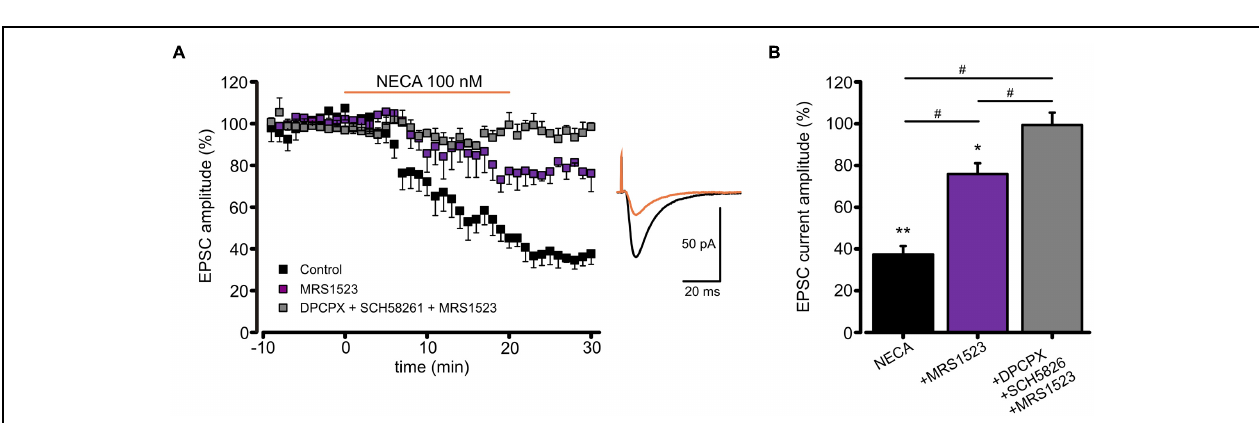
FIGURE 6 | Modulation of EPSC amplitude by NECA depends on A 3 R. (A) Left , time course of EPSC depression induced by adenosine receptor agonist NECA (100 nM) in hippocampal CA1 neurons in from acute slices in control conditions (black; n = 7; p < 0.05 at t = 25 min), in the presence of A 3 R antagonist MRS1523 (100 nM) (purple; n = 7; p < 0.05 respect to control and NECA alone) and in the presence of DPCPX + SCH58261 + MRS1523 (gray, n = 7). Right , sample EPCSs recorded in a CA1 pyramidal neuron in control and following NECA application. (B) Bar chart showing the effect of NECA (100 nM) alone (black), in the presence of the A 3 R antagonist (MRS1523 100 nM, purple) and in the presence of all three blockers (DPCPX + SCH58261 + MRS1523 gray, n = 7). ∗ p < 0.05, ∗∗ p < 0.01, # p < 0.05.